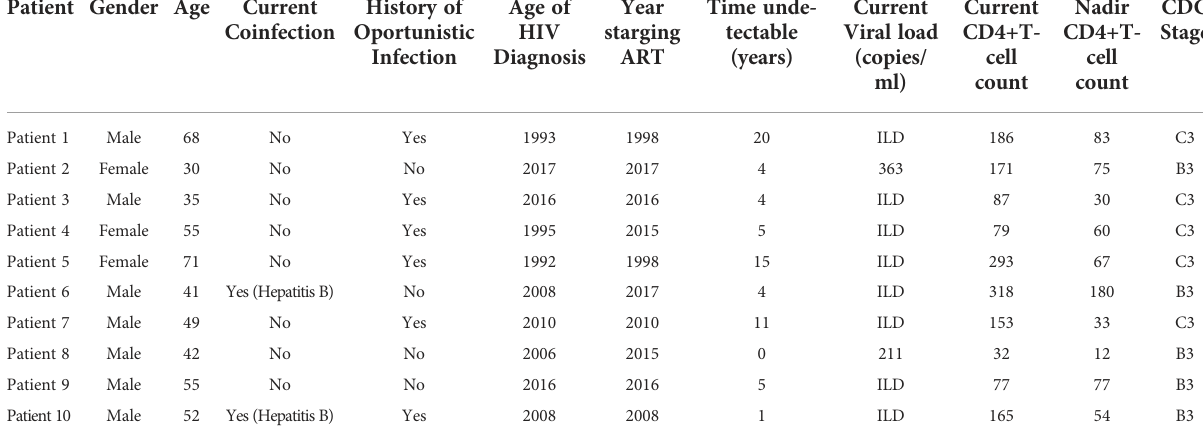
TABLE 2 HIV-INR patient